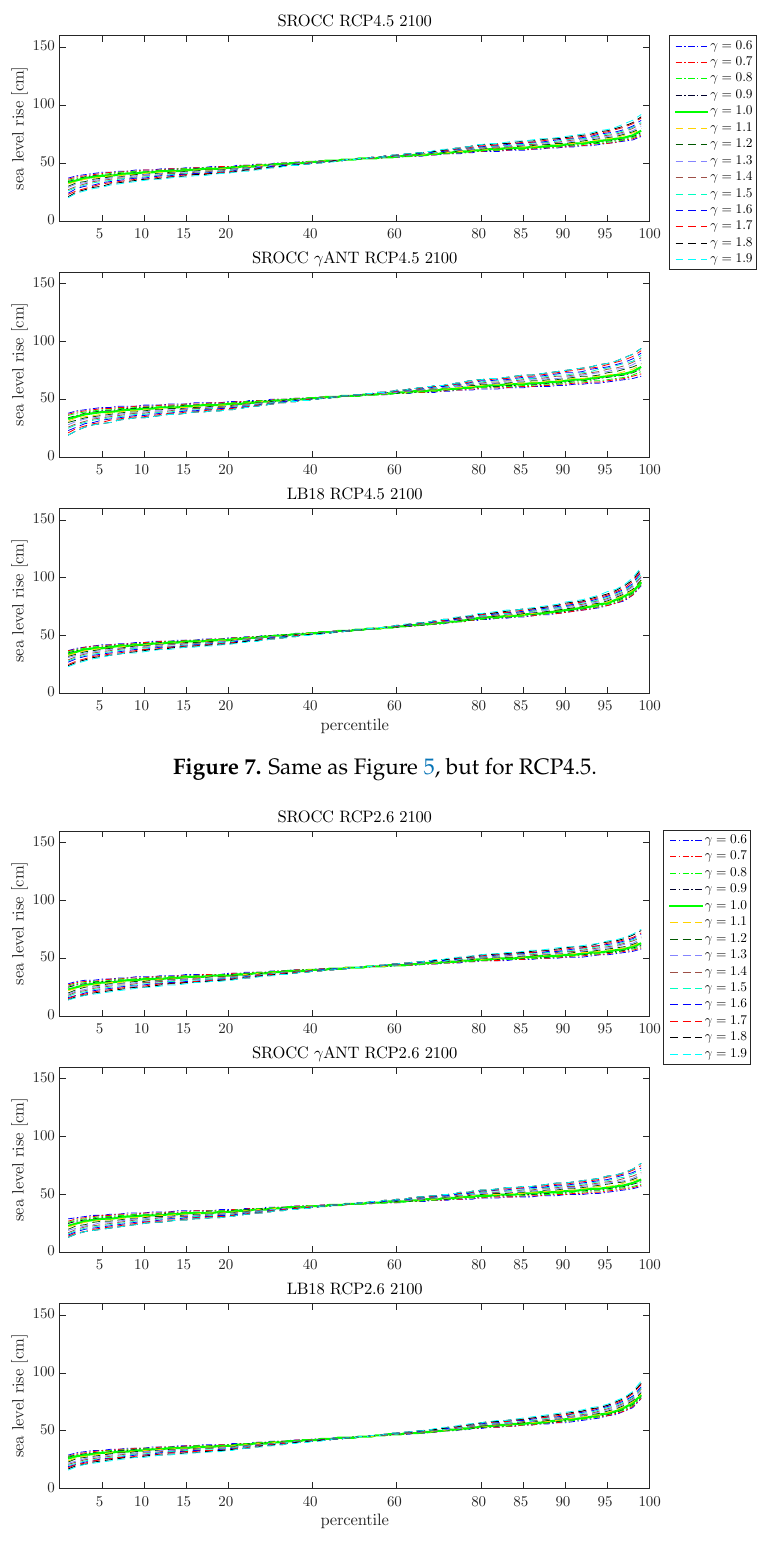
Figure 8. Same as Figure 5, but for